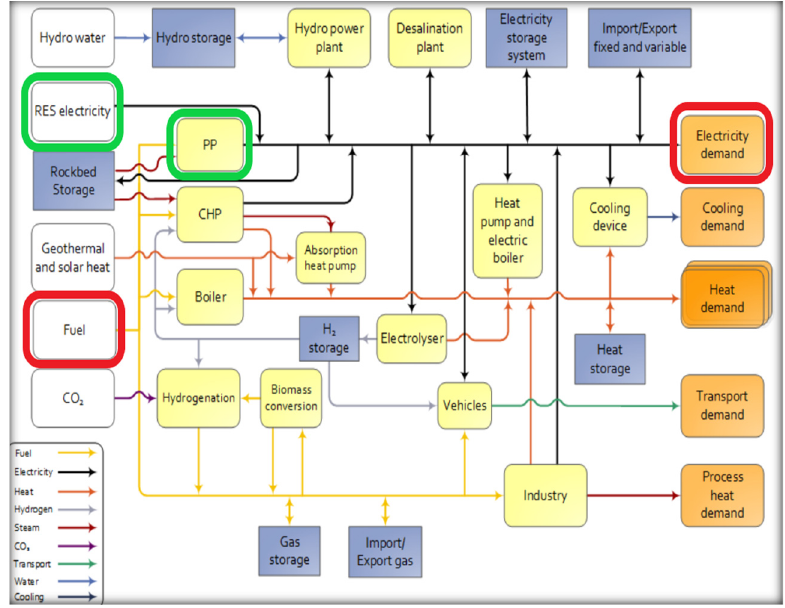
Figure 2. Input-output arrangement of EnergyPLAN ® , where the main blocks involved in this study are highlighted in red (inputs) and green (outputs).